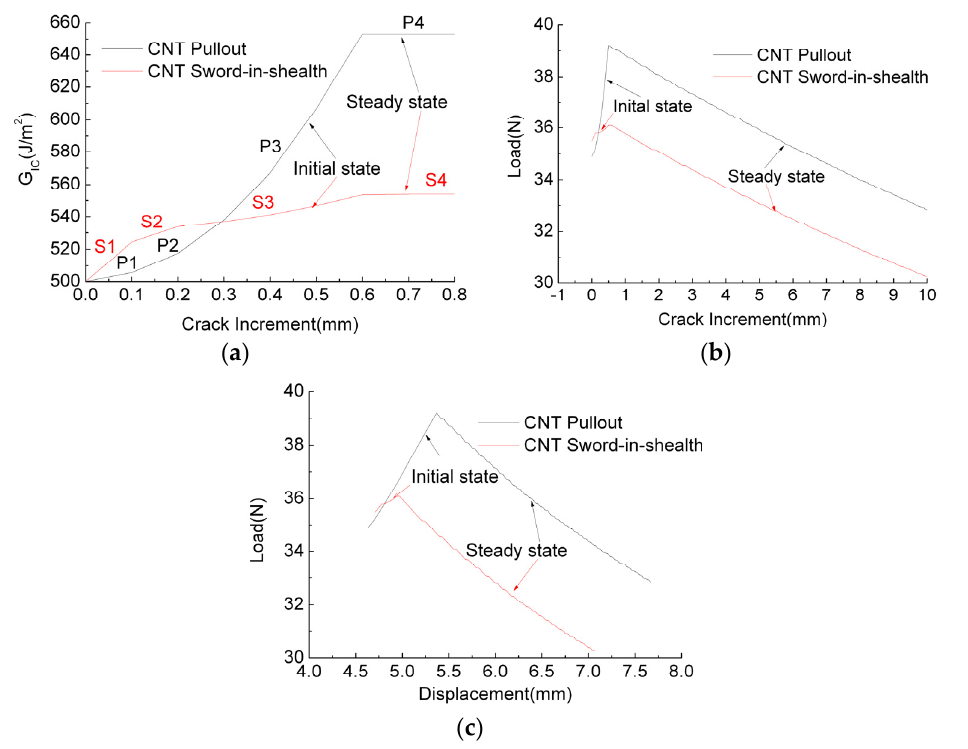
Figure 7. Delamination properties prediction: ( a ) typical G R curves; ( b ) typical R curves; and ( c ) typical load with displacement.